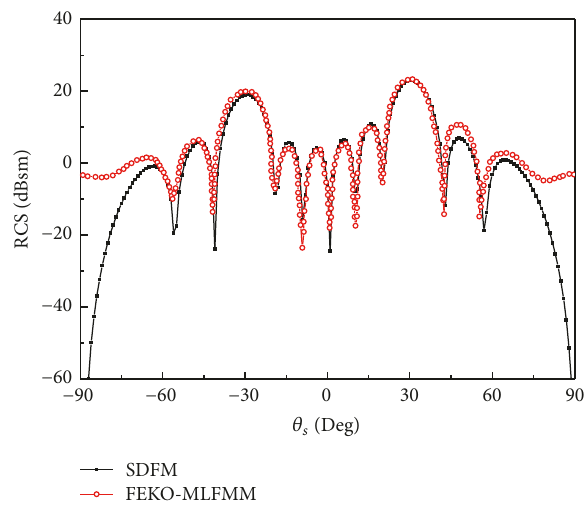
Figure 4: Bistatic RCS results for the facet (HH-polarization).